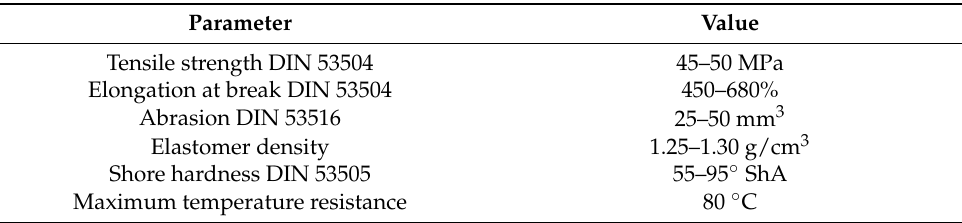
Table 3. Key mechanical properties of the polyurethane used in the cutting force tests [20]. Parameter